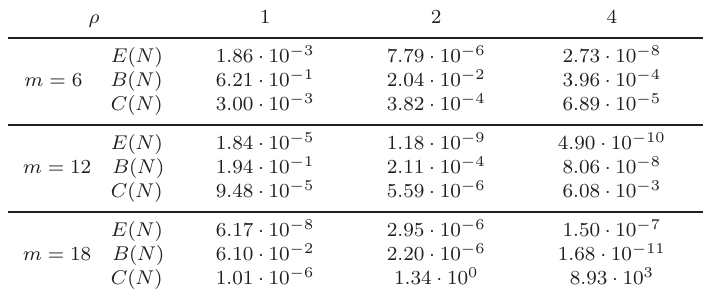
Table 6 for the parameters α opt,R , N opt,R and α opt,ρ , N opt,ρ , respectively.